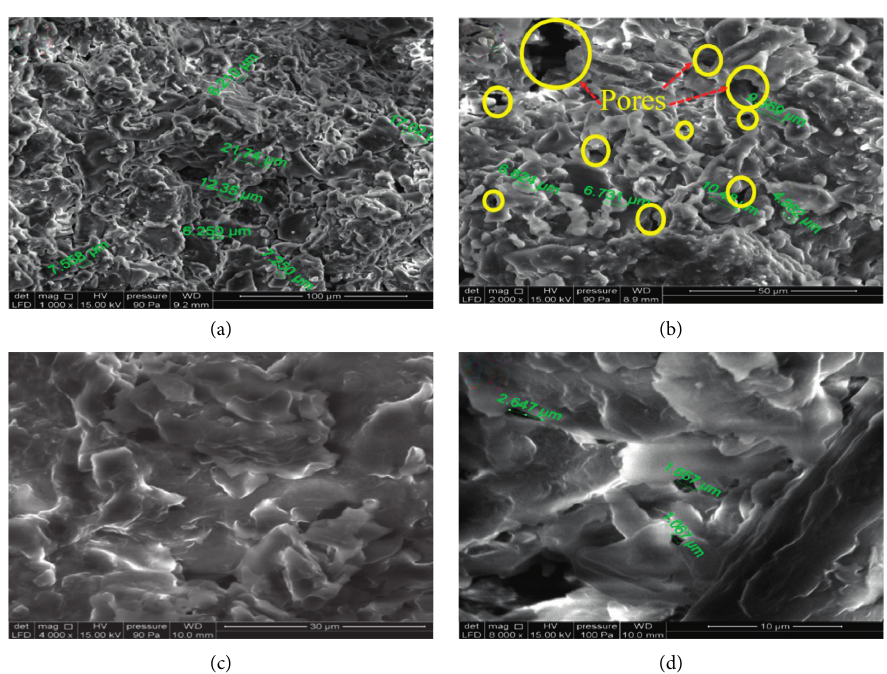
Figure 2: Scanning electron microscopy (SEM) images of RDP: (a, b) before adsorption; (c, d) after